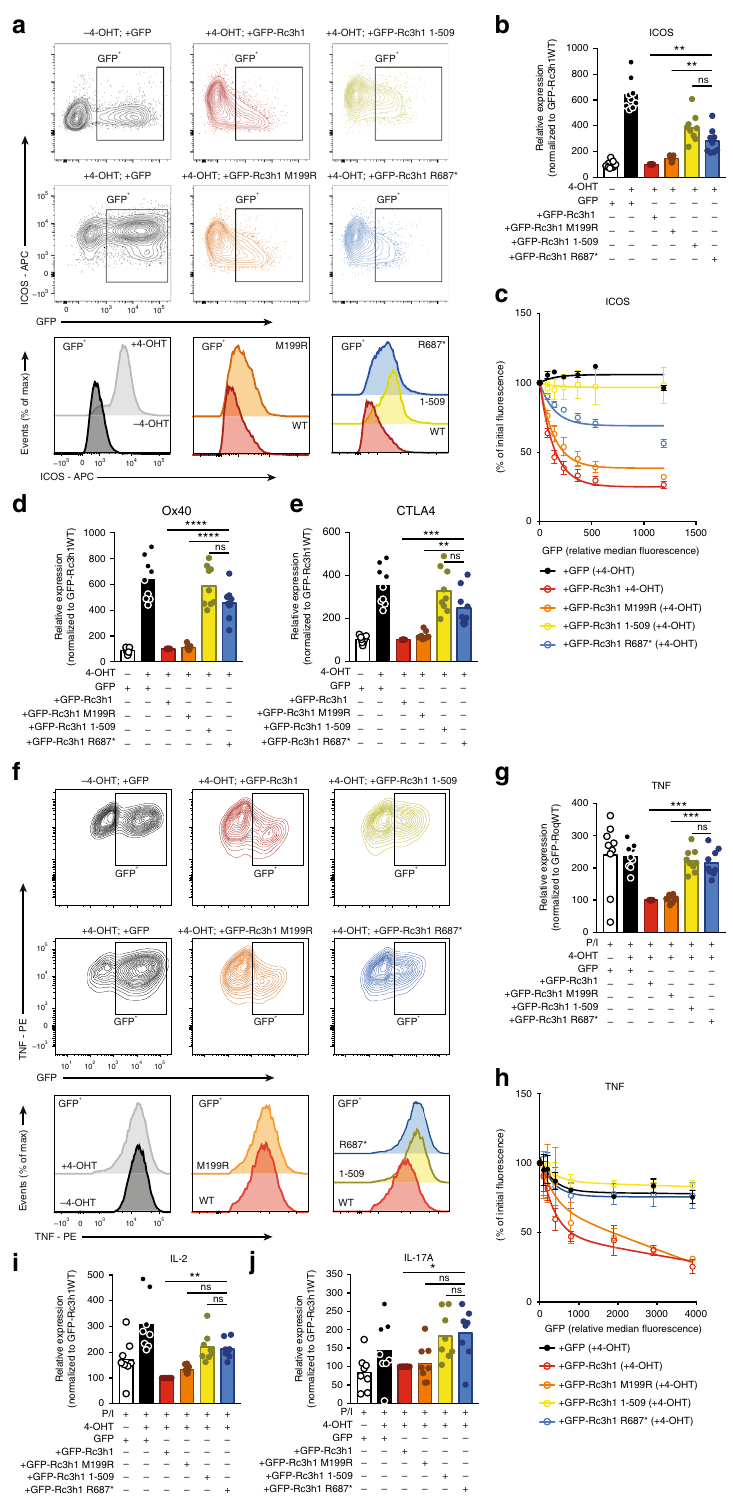
Reagents . Cells were treated with PMA (81 nM in human or 20nM in murine studies; Sigma Aldrich; P8139) and ionomycin (1 μ M; Sigma Aldrich; I3909) for indicated time points. Mepazine acetate (Vitas-M Laboratory Ltd; STK386548) was used at a concentration ranging between 6.5 and 20 μ M. Sodium arsenite (Sigma Aldrich; S7400) was dissolved in complete medium at a fi nal concentration of 1M and used at 1mM. Cultured monocytes were stimulated with 100 ng/mL